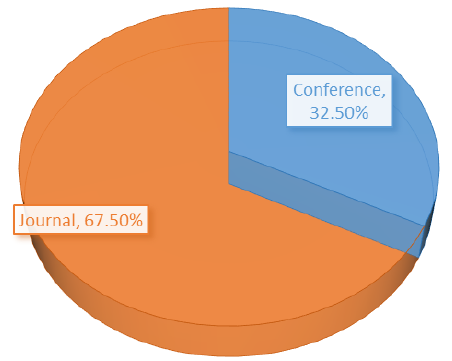
Figure 6. Distribution based on publication type.